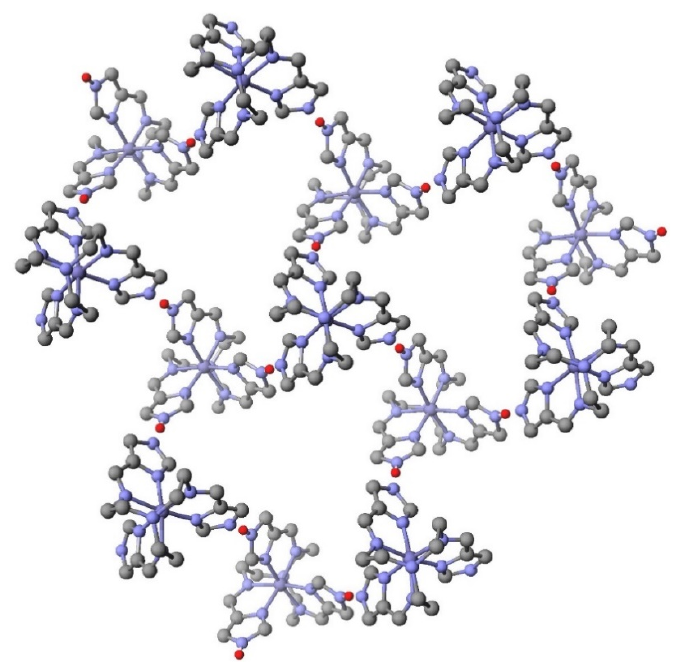
Figure 12. Structure of a portion of the polymeric 2D sheet of {[Fetren)(4-ImH) 3 ][Fetren(4-Im) 3 ]}(BF 4 ) 2 at 100 K. The counteranions and all hydrogen atoms except those participating in N imidazole –H ... N imidazolate bonding (shown in red) have been omitted for clarity. Note the repeating hexagonal groupings of iron complexes. Table 6. Structural data for {[Fetren(2Me-4ImH) 3 ][Fetren(2Me-4Im) 3 ]}NO 3 and {[Fetren)(4-ImH) 3